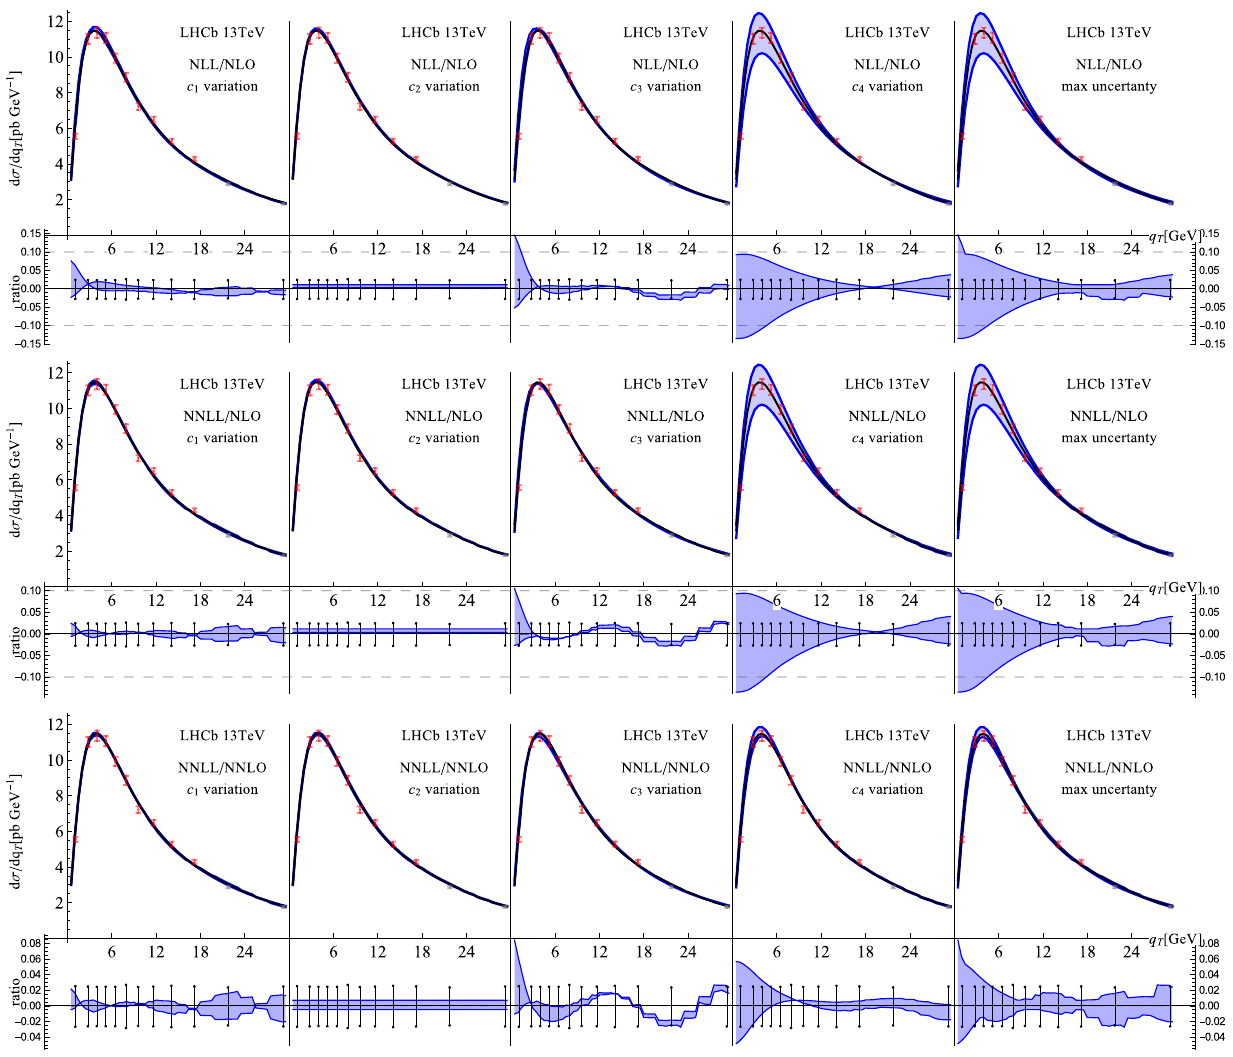
Fig. 5 Theoretical error-bands and experimental data points for LHCb (13 TeV) experiment at 13–14 GeV. The theoretical error is estimated changing c 1 , 2 , 3 , 4 in the range ( 0 . 5 , 2 ) at each perturbative order. The